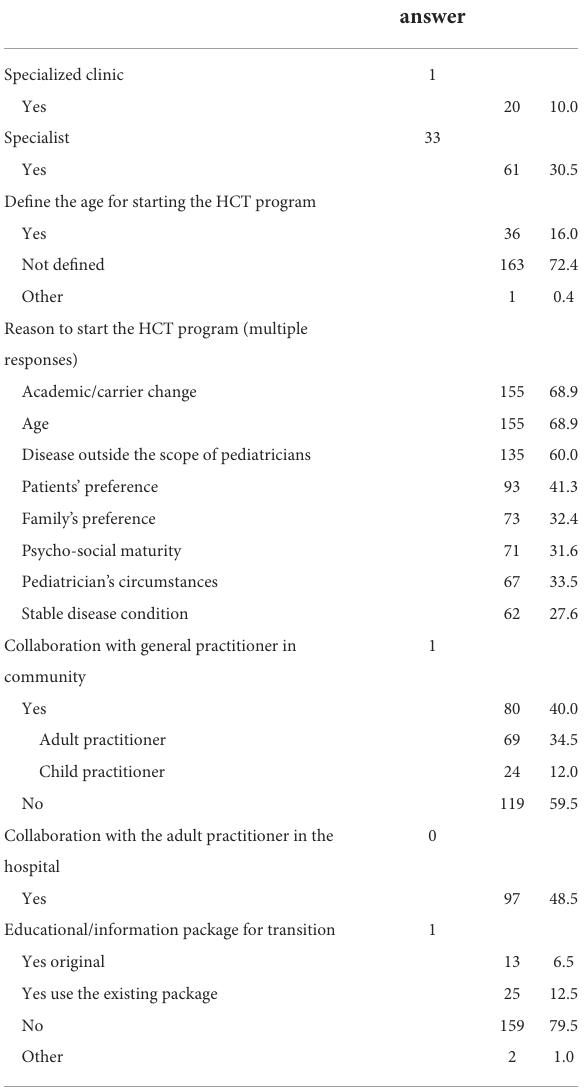
TABLE 2 Medical care system for transfer to adult departments ( n =